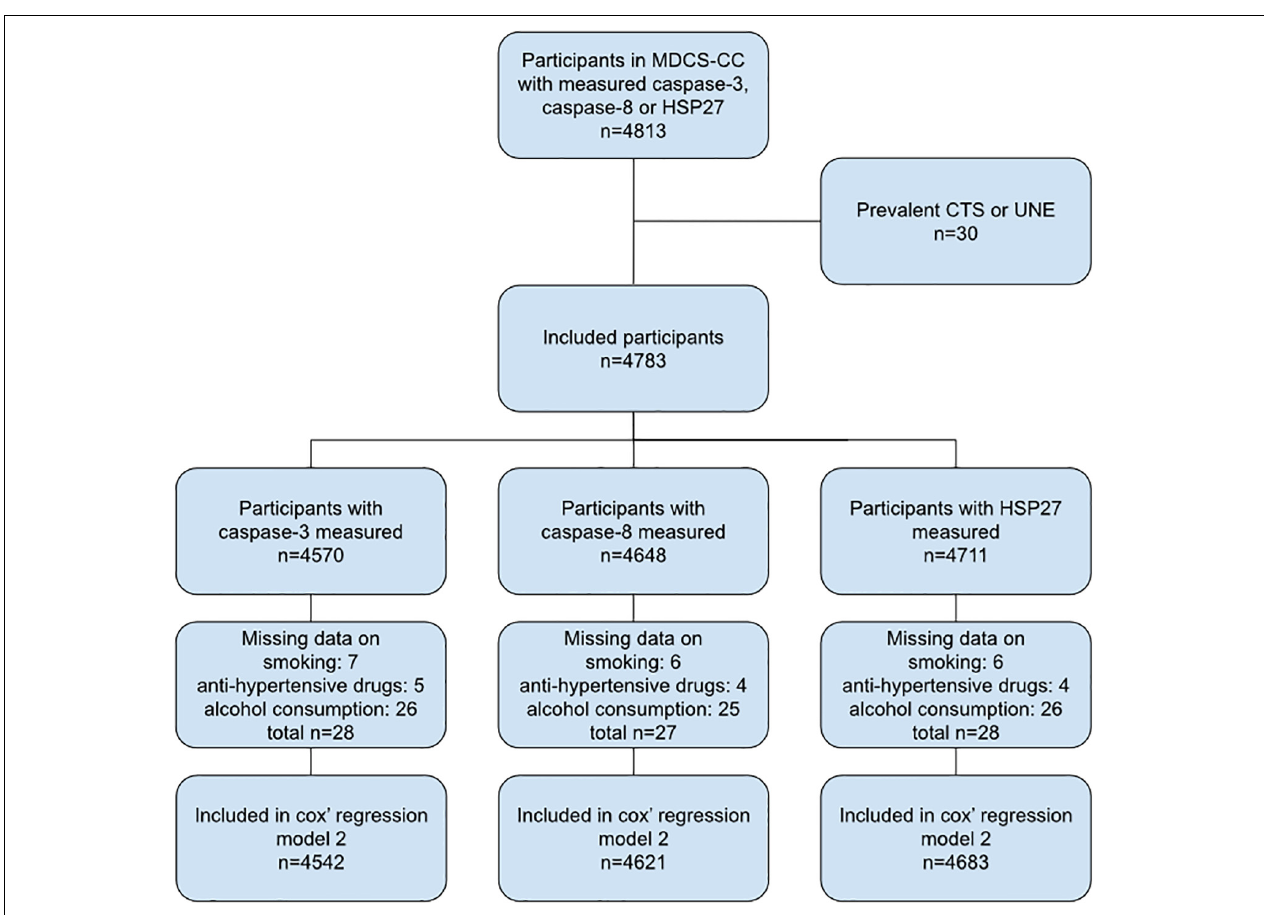
FIGURE 1 | Flow chart of included study participants. MDCS-CC, The Malmö Diet and Cancer Study—Cardiovascular cohort; CTS, carpal tunnel syndrome; UNE, ulnar nerve entrapment at the elbow.